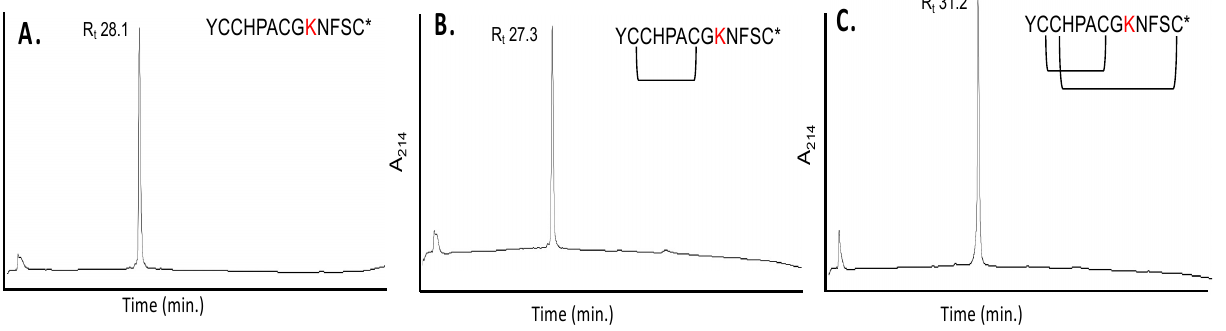
Figure 3. RP-HPLC/UV profiles represent changes in elution time of α -[P9K] conotoxin OI during the sequential two-step oxidation process. ( A ) The synthesized, cleaved, and RP-HPLC/UV purified α -[P9K] conotoxin OI was eluted at 28.1 min. ( B ) Purified α -[P9K] conotoxin OI after first bond formation using 0.1 M NH 4 HCO 3 , eluting at 27.3 min. ( C ) Purified α -[P9K] conotoxin OI fully